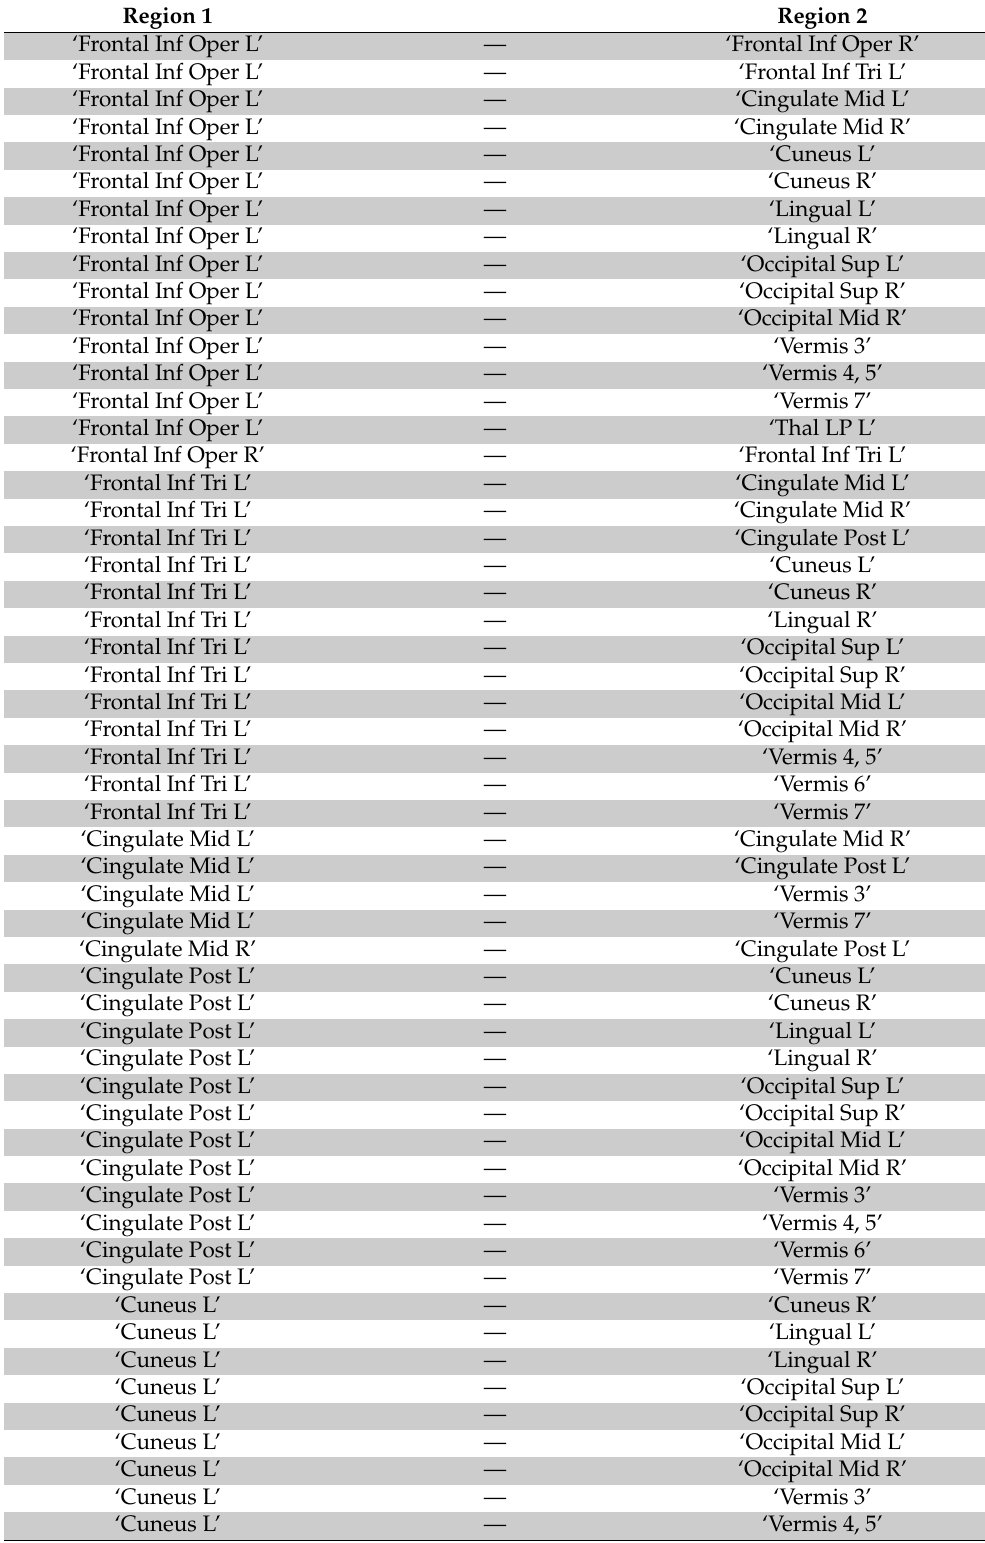
Table A1. List of significant (found with the FDR method) connections between positive clusters nodes (See Figure 2) for the node centrality